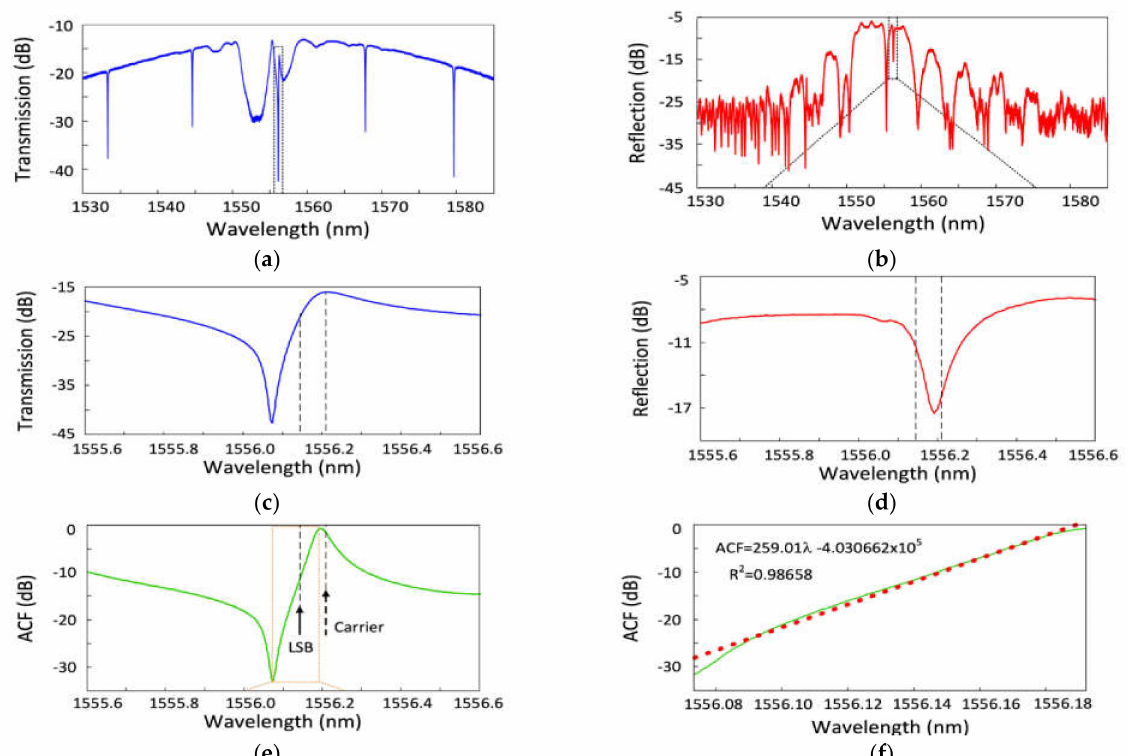
Figure 26. ( a ) Transmission spectral response of the device; ( b ) reflection spectral response of the device; ( c , d ) zoomed-in views of the region around the Fano resonance; ( e ) amplitude comparison function; ( f ) zoomed-in view of the linear region of the ACF with linear fitting (Adapted with permission from Ref [41]. Copyright 2019,